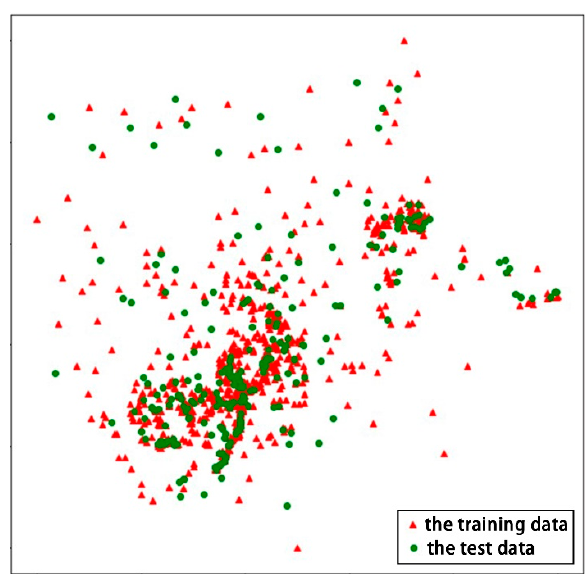
Figure 8. Schematic diagram of the training data and test data distributions.